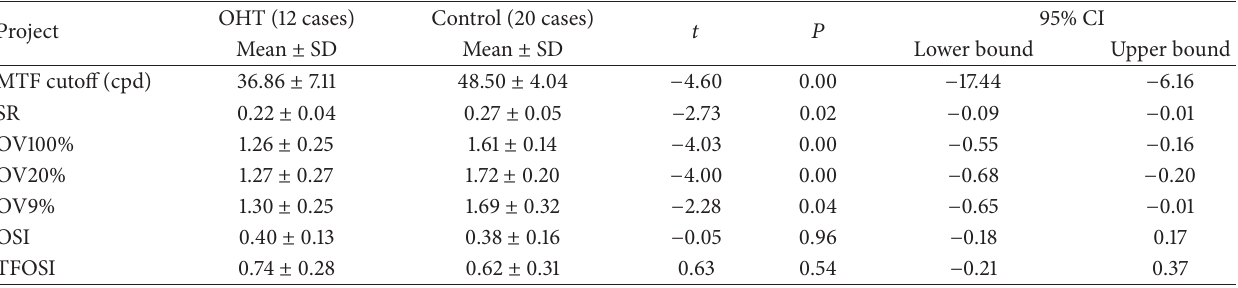
Table 2: Optical quality of OHT and